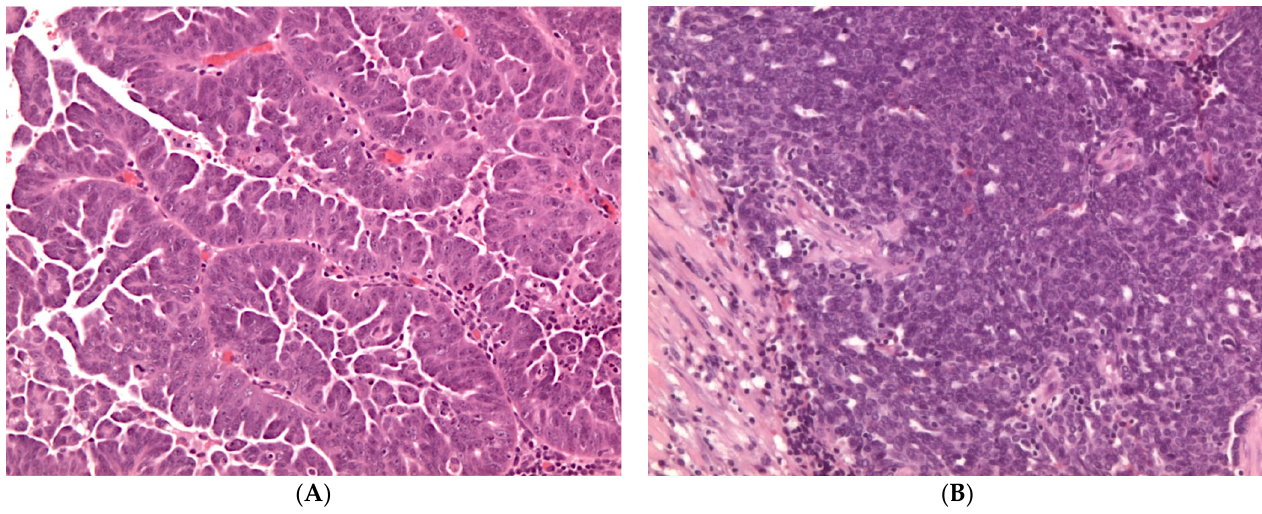
Figure 1. ( A ) Histologic appearance of classic high ‐ grade serous carcinoma (HGSC) (hematoxylin and eosin, H&E, ×100); ( B ) Solid, pseudoendometrioid, transitional cell carcinoma ‐ like (SET) variant of HGSC (hematoxylin and eosin, H&E, ( B ) Solid, pseudoendometrioid, transitional cell carcinoma-like (SET) variant of HGSC (hematoxylin and eosin, H&E, × ×100).